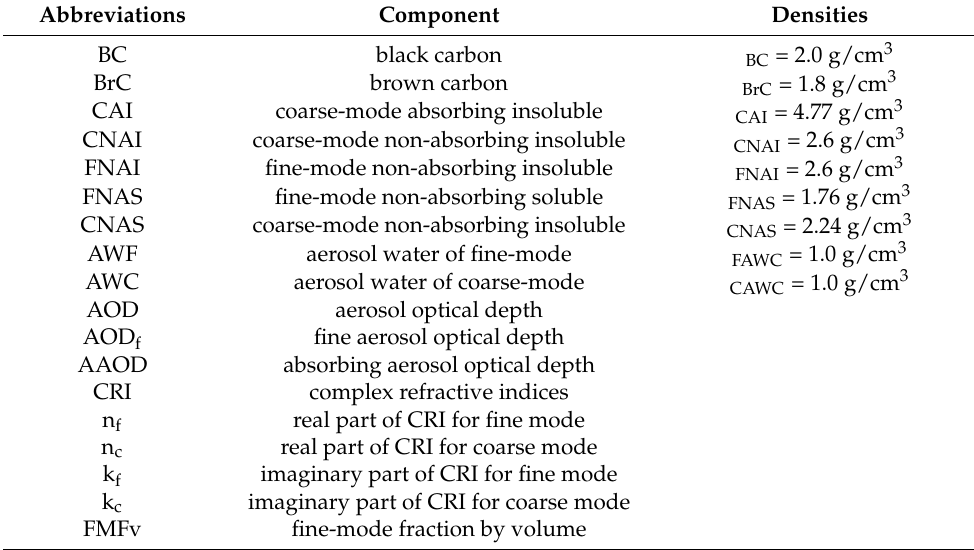
Table 1. Abbreviations of aerosol components and optical and microphysical